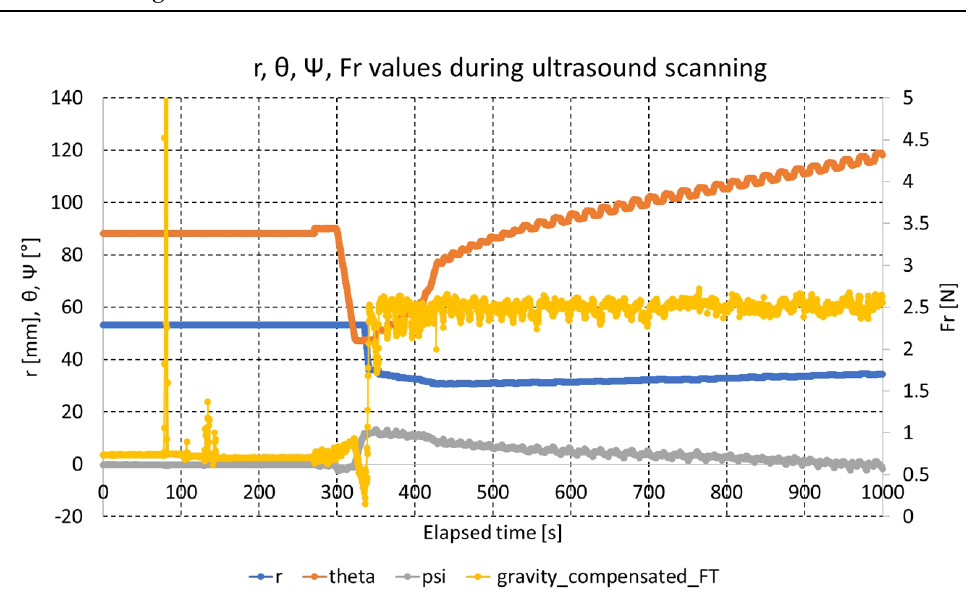
Figure 12. r, θ , ψ , and Fr measurements during ultrasound scanning.